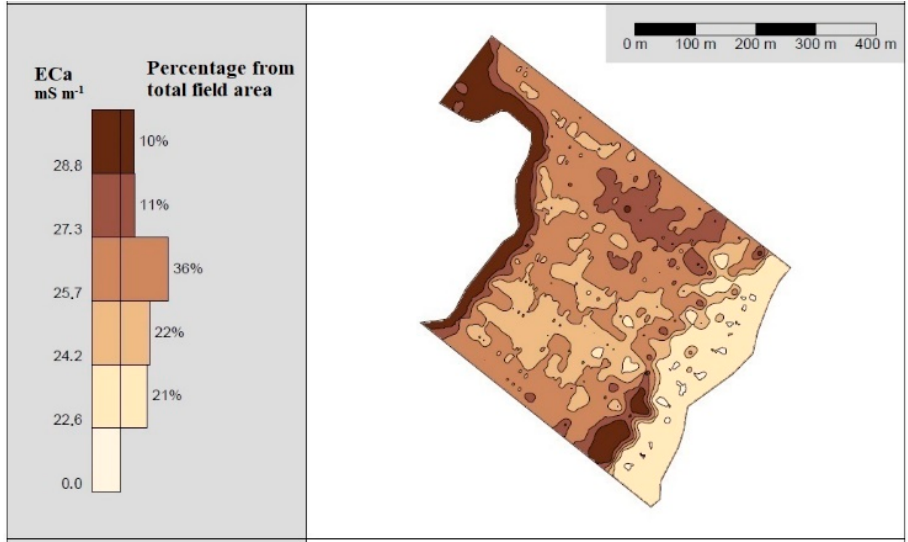
Figure 6. ECa map representing differences in soil properties in the field. The colored parameter variations were created by the authors using an EM38-MK2 device [22].